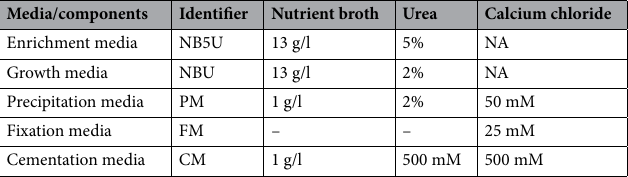
Table 2. Details of the media used for enrichment, isolation, and